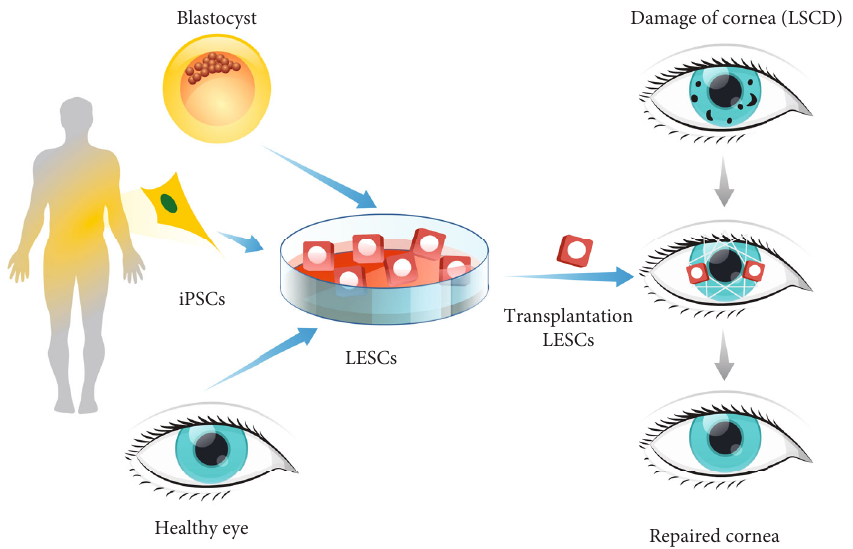
Figure 2: Derivation and therapeutic potential of